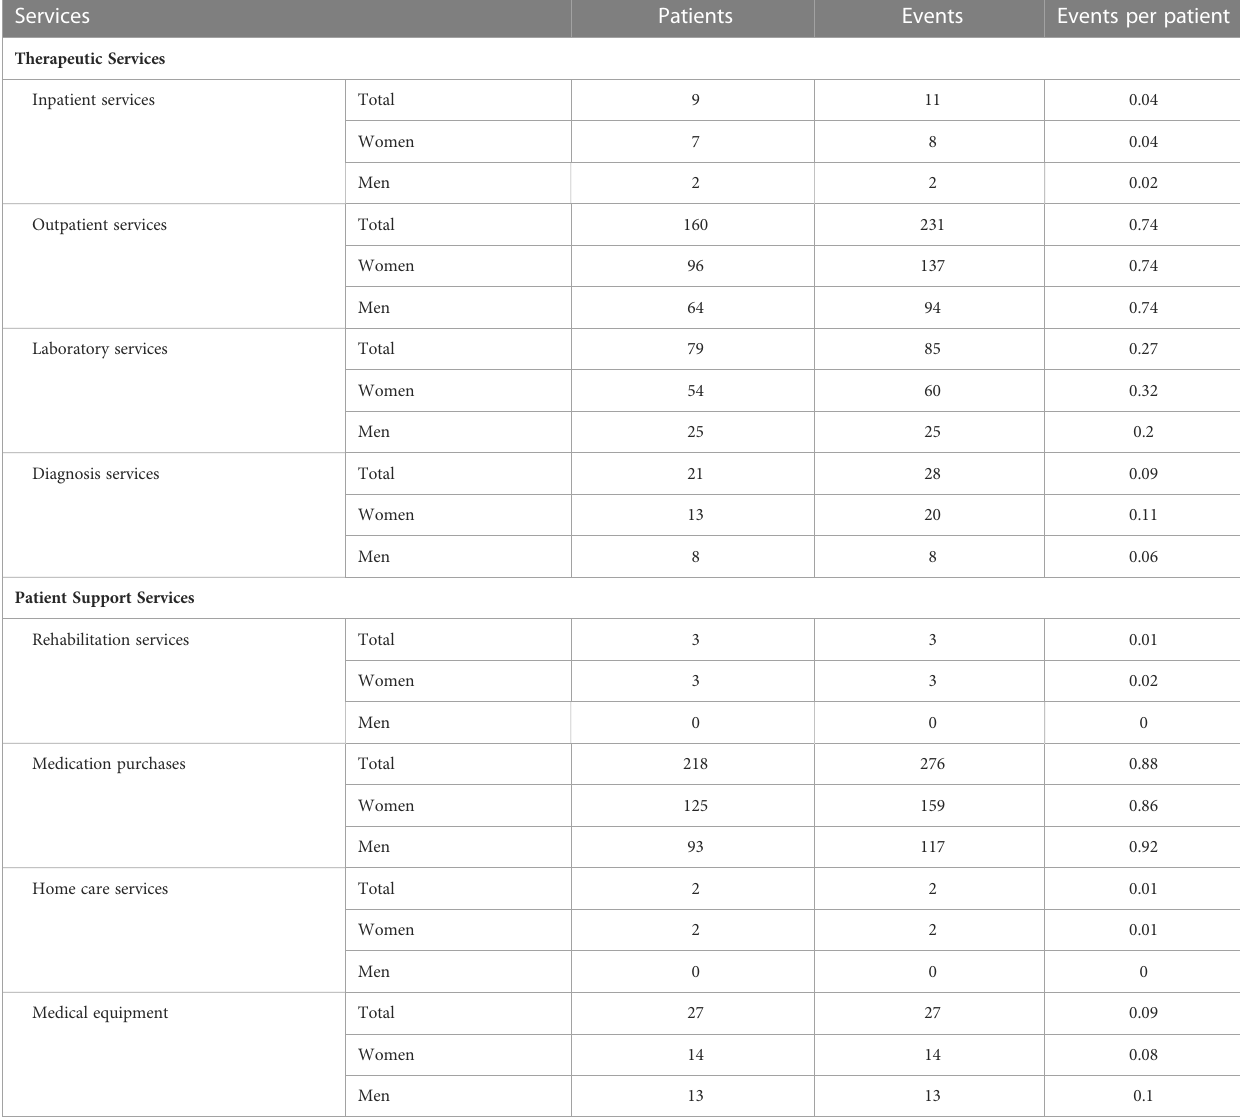
TABLE 2 Monthly utilization of healthcare services among patients with